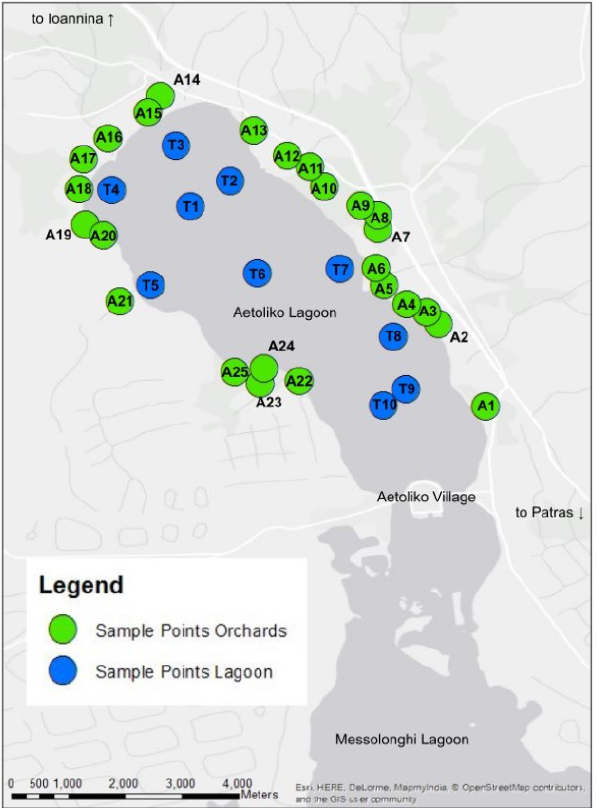
Figure 2. Overview of the spatial distribution of the samples points. Green dots stand for soil sample points in the orchards and blue points are bottom sediment lagoon samples.